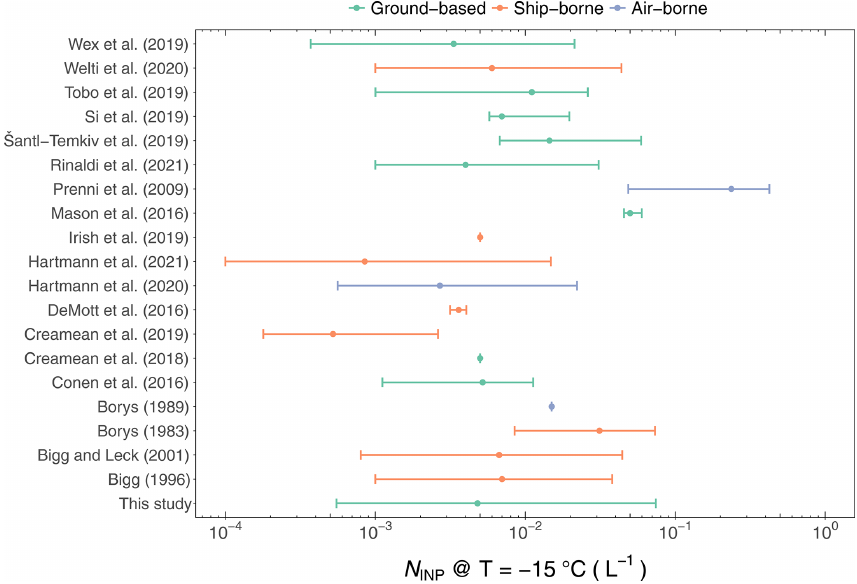
Figure 9. Comparison of INP concentrations at − 15 ◦ C from this study to selected Arctic field campaigns as a function of measurement platform. The median N INP is given in colored dots, and the colored error bars indicate the 5%–95% quantile of the corresponding data set.